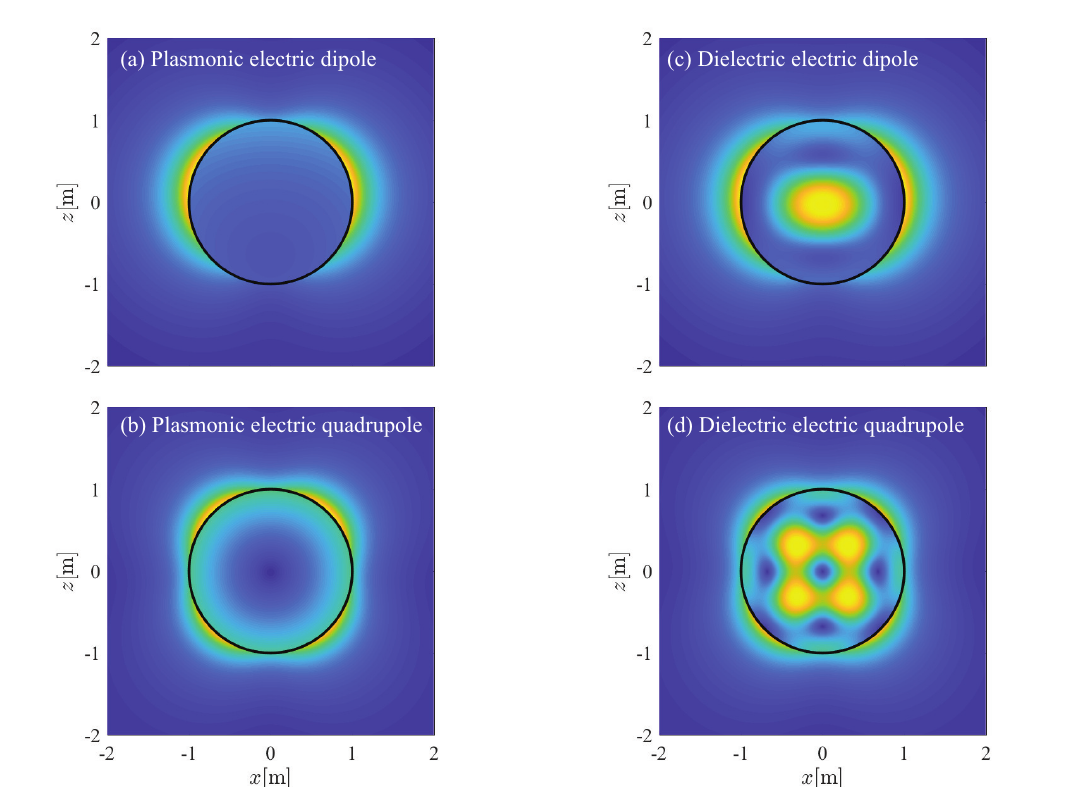
Figure 7. The amplitude of the scattered electric field distribution for a sphere of x = 0.75